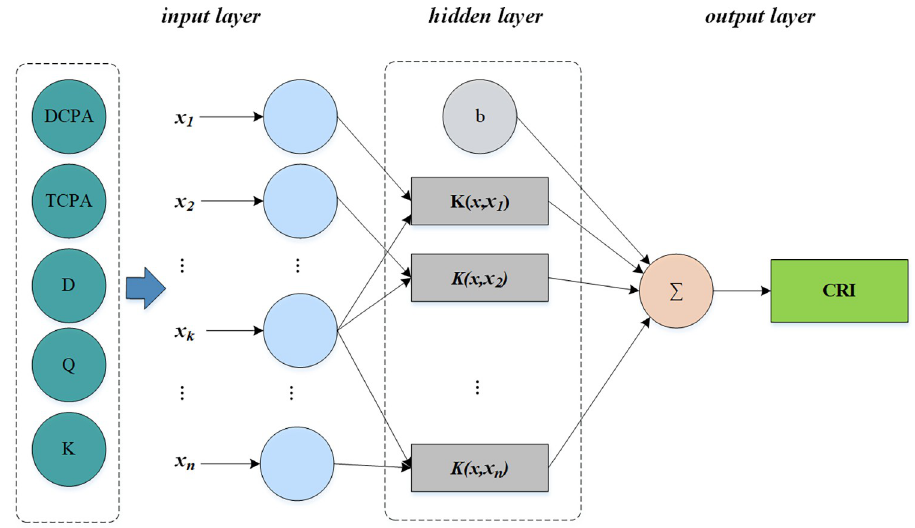
Fig 3. Schematic diagram of the CRI model based on the